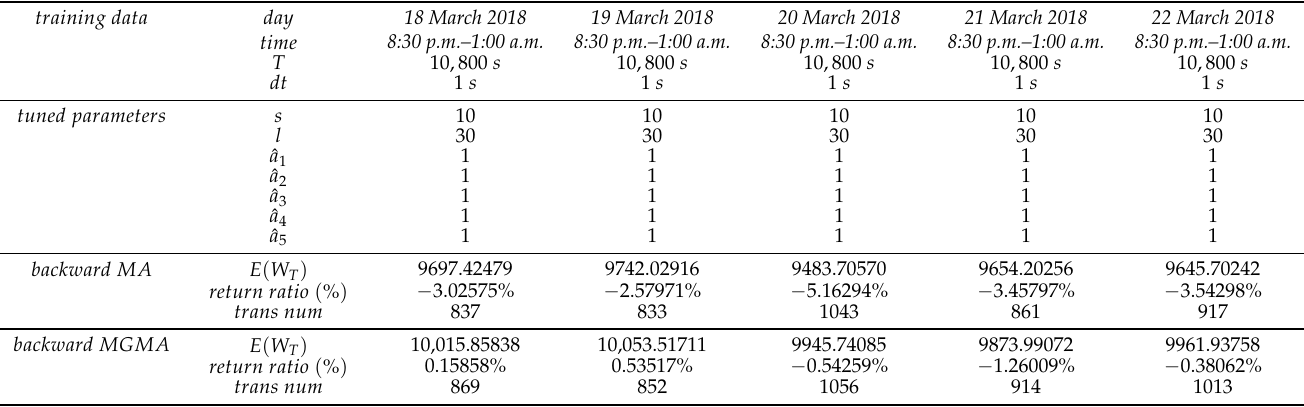
Table 10. Case 2—MGMA strategy performance summary for HuaXia ETF and HuaTai ETF on day 1 (18 March 2018) to day 5 (22 March 2018) training data. training